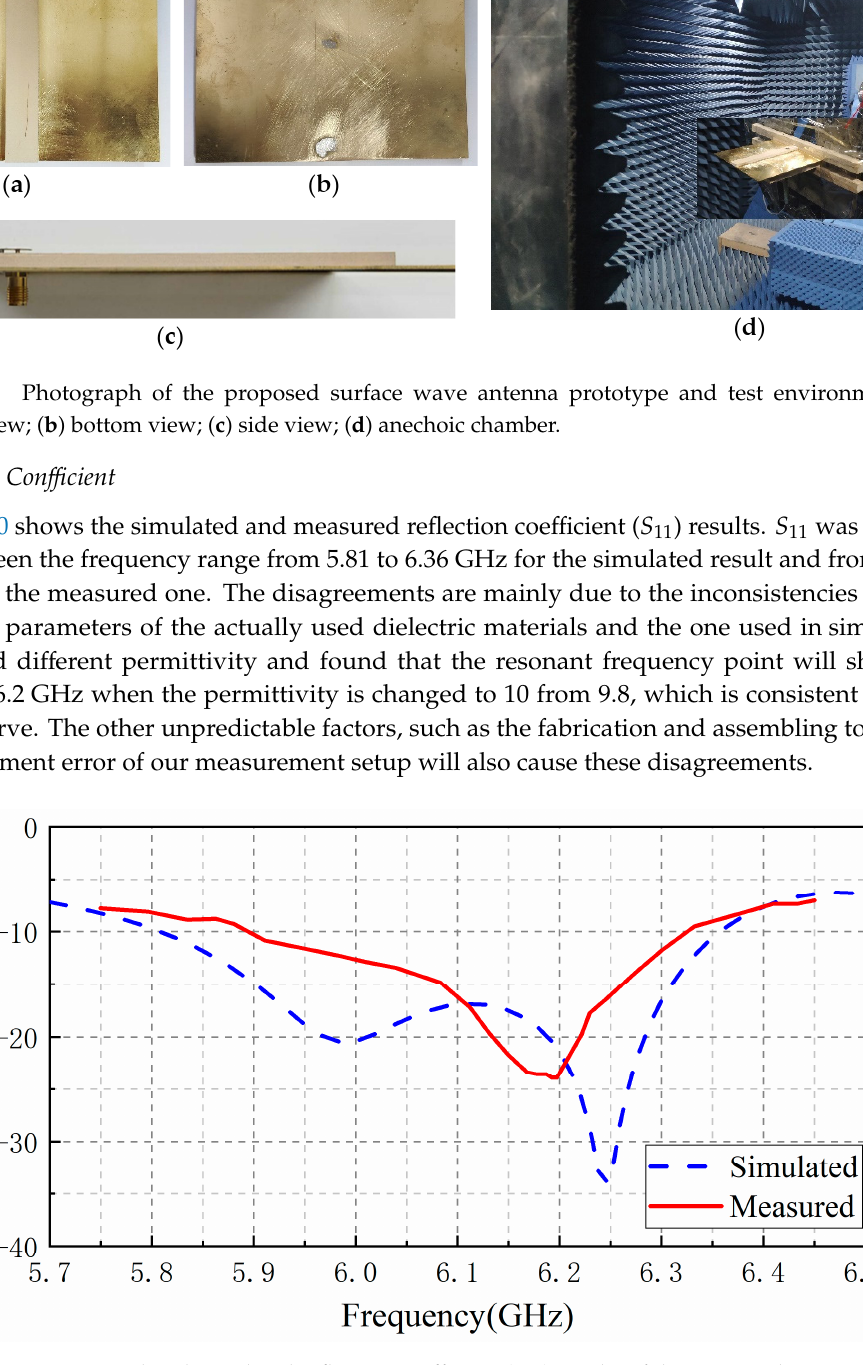
frequencies: ( a ) 5.8 GHz; ( b ) 6 GHz; ( c ) 6.2 GHz.